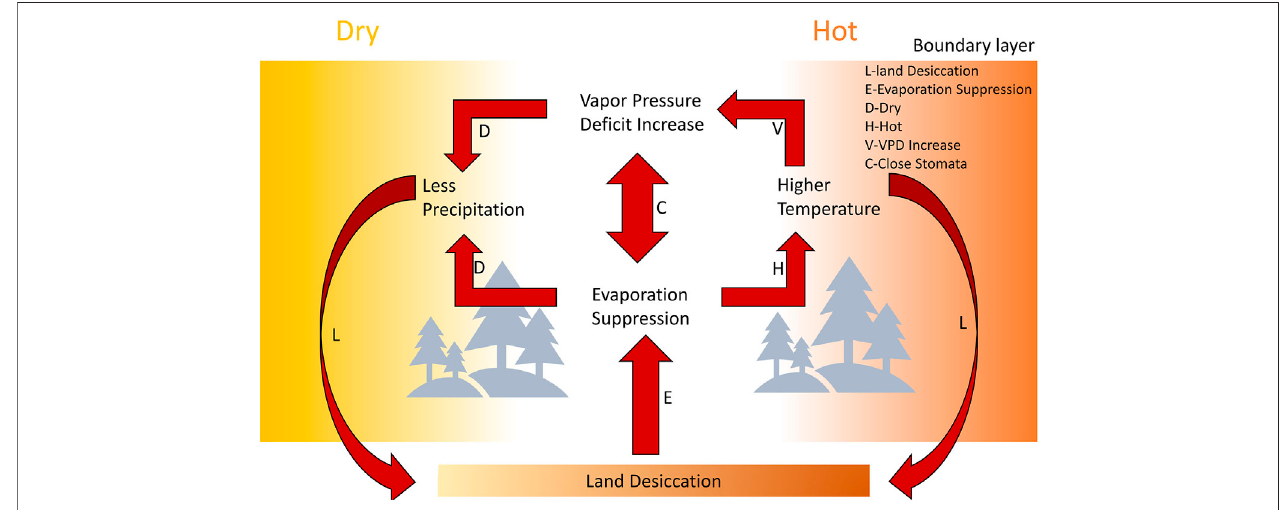
FIGURE 1 | Physical mechanisms of compound hot-dry extremes and land-atmosphere interactions. The physical mechanisms are based on previous studies on compound hot-dry extremes (e.g., Mazdiyasni and AghaKouchak, 2015; Massmann et al., 2019; Miralles et al., 2019; Schumacher et al., 2019; Tavakol et al., 2020a).